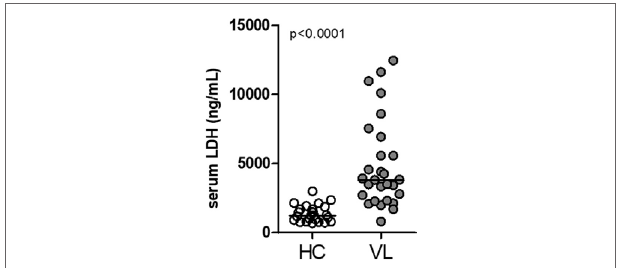
FigUre 1 | Circulating levels of lactate dehydrogenase (LDH) in patients with visceral leishmaniasis (VL). LDH levels from serum sample obtained from patients with VL ( n = 33) and healthy controls individuals (HC; n = 25) from an endemic area in the Northeast of Brazil was estimated by colorimetric assay (28, 31). Mann–Whitney U test was used to verify statistical difference between VL and HC individuals. Circles represent individual values. Black bars represent median values.